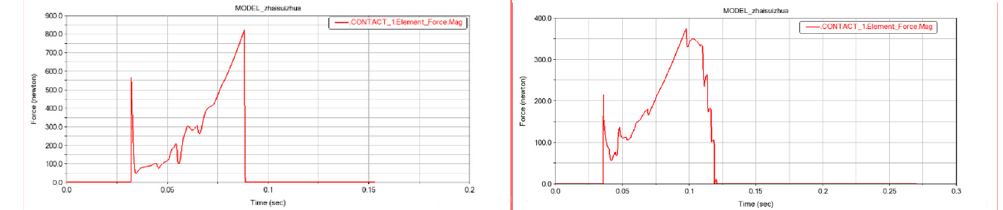
Figure 7. Contact force on the ear when the forward speed is 1.71 m/s and the claw picking speed is 2 m/s.